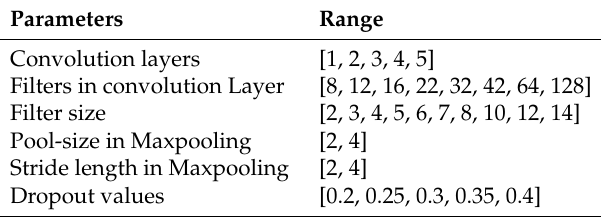
Table 3. Hyper-parameters tuning